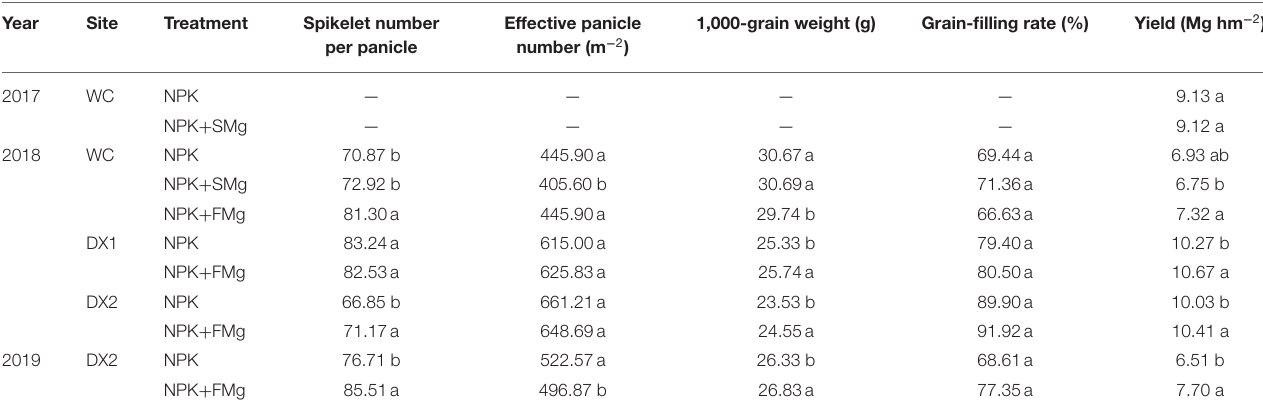
TABLE 4 | Rice yields and yield components for different nutrient management